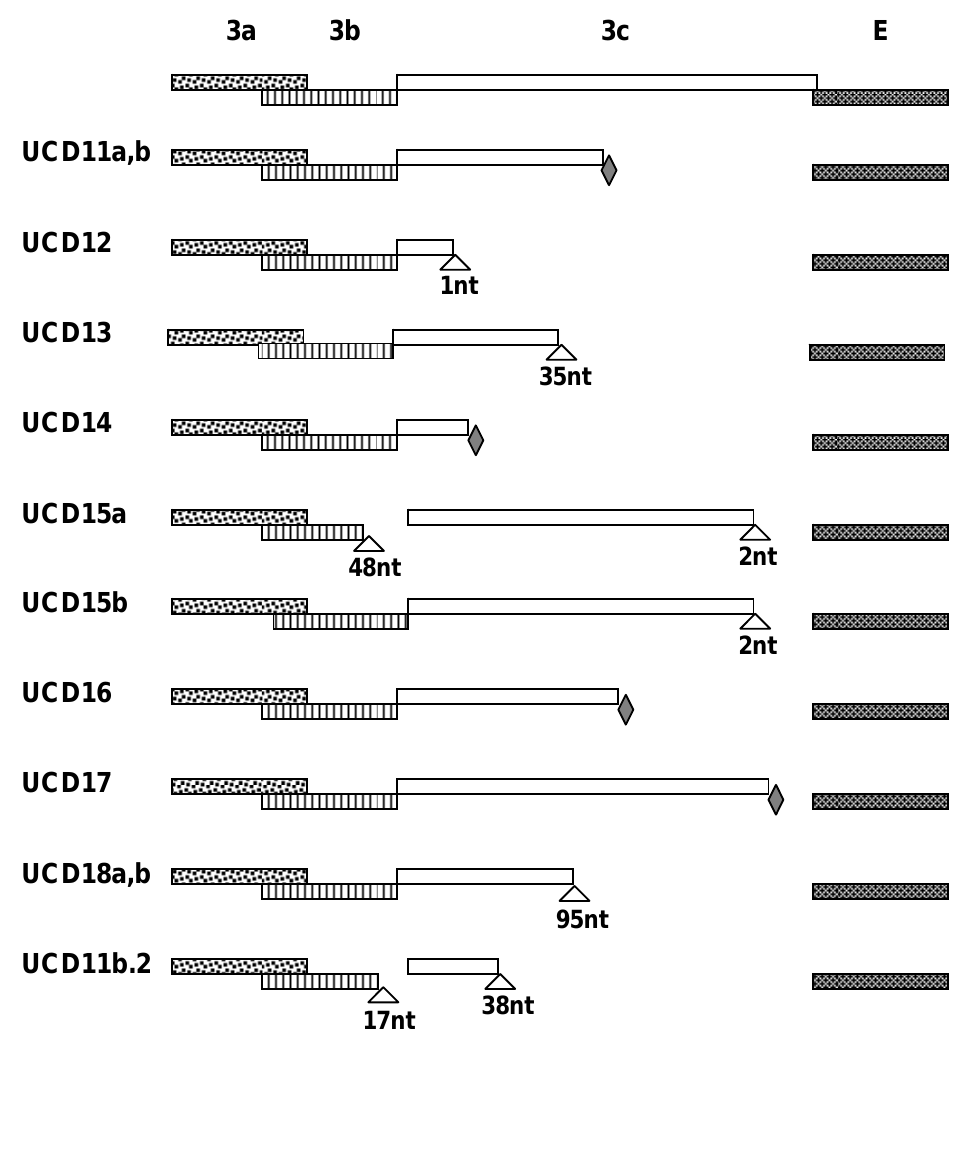
Figure 2. Cartoons show the 3a-c and E gene segments of FIPV-UCD11 to 18 and a cat- passaged variant of FIPV-UCD11b (FIPV11b.2). Deletions are indicated with triangles